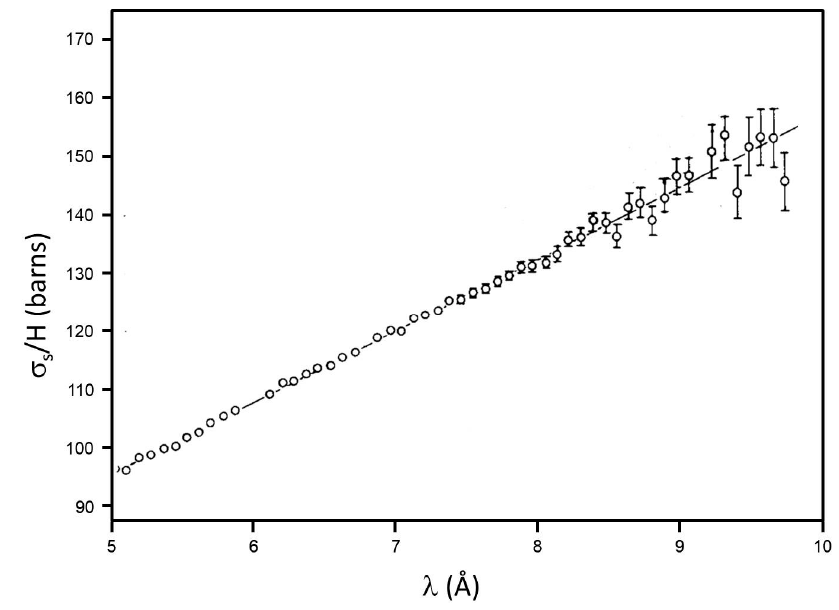
Figure 1. Total scattering cross-section per H atom, σ s /H, at room temperature, for PDMS (polymer polydimethylsiloxane) as a function of the neutron wavelength λ . Experimental points and adjusted straight line, with slope related to the barrier for CH 3 rotations.